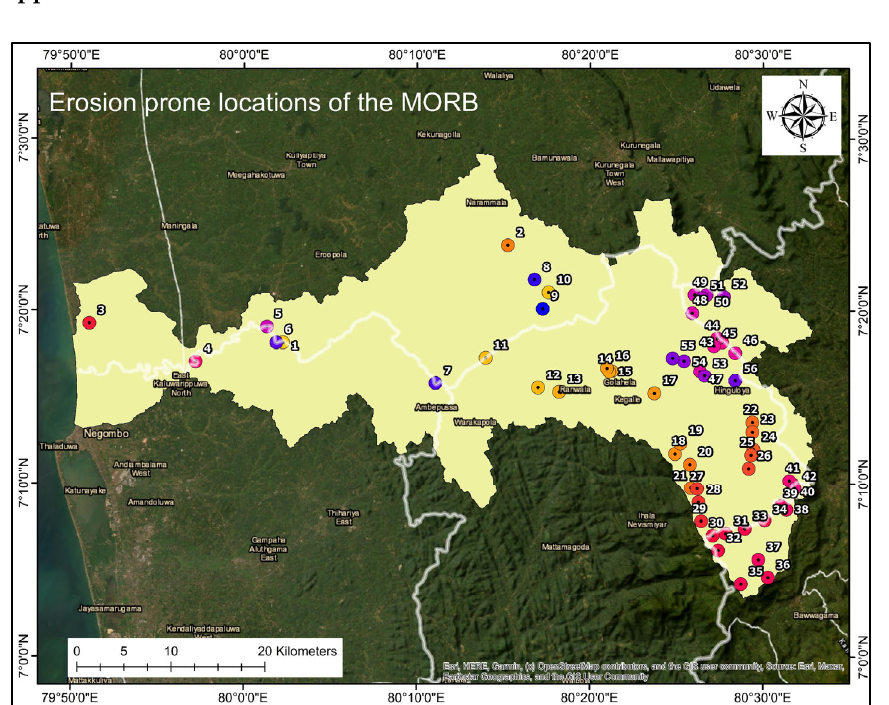
Figure A1. Extremely high soil erosion ‐ prone locations map of the MORB. Table A1. Coordinates of extremely high soil erosion-prone locations in the